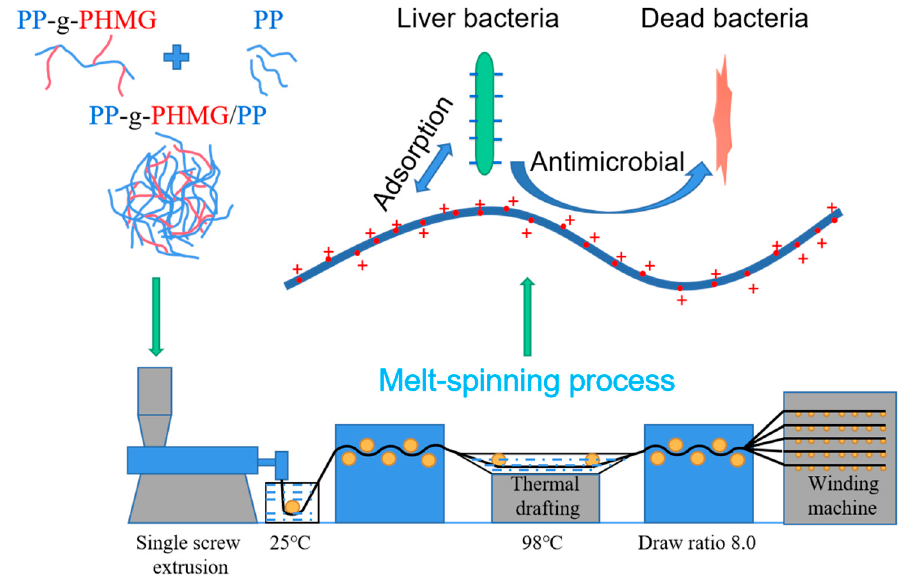
Figure 8. Preparation process and antibacterial mechanism of PP − g − PHMG/PP − blended monofilaments.